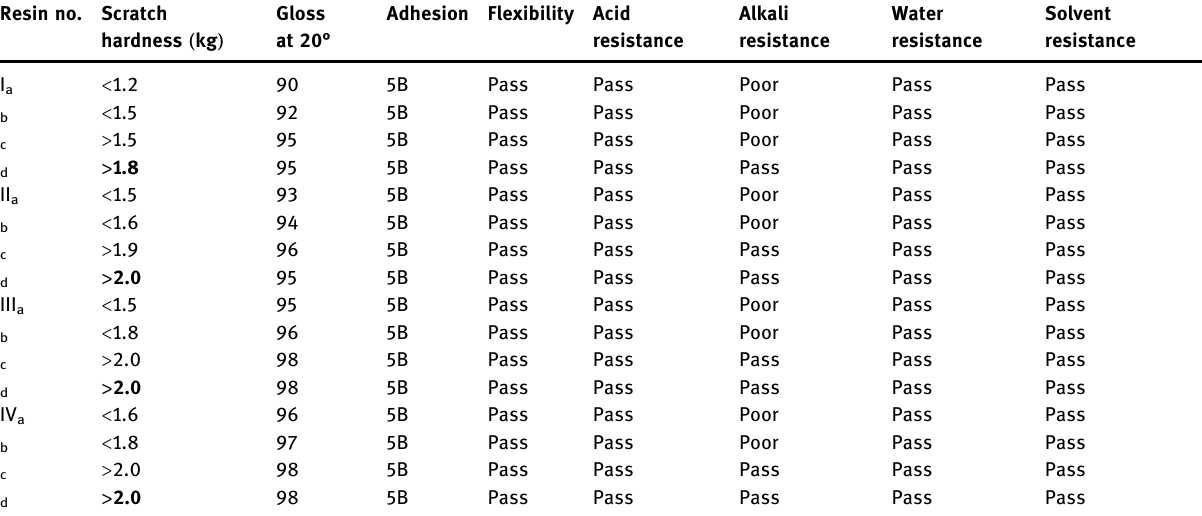
Table 5: Mechanical characteristics of various modi fi ed alkyd resins Resin no. Scratch